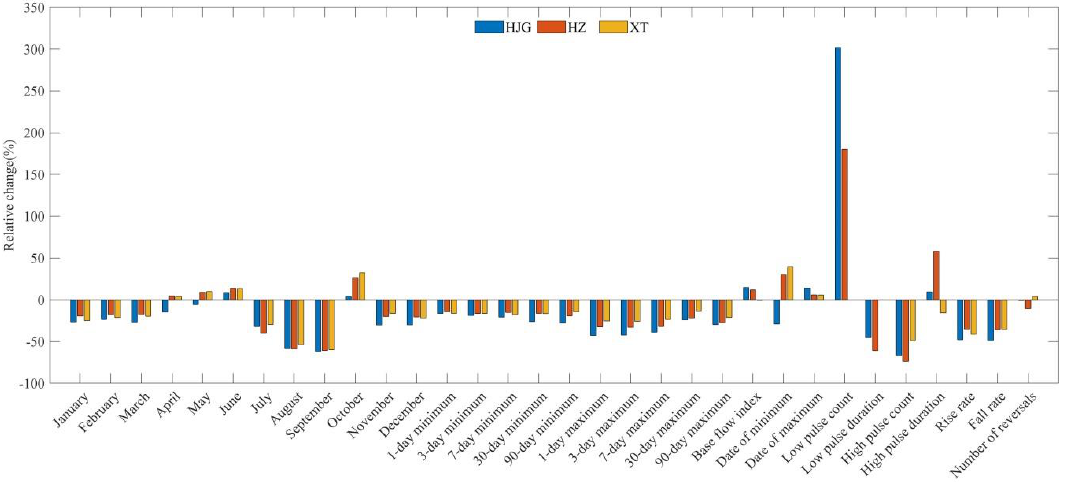
Figure 10. The relative change of 33 IHA indicators at HJG, HZ and XT between the transition and post-impact periods. Table 5. Changes of IHA metrics in the post-impact period.